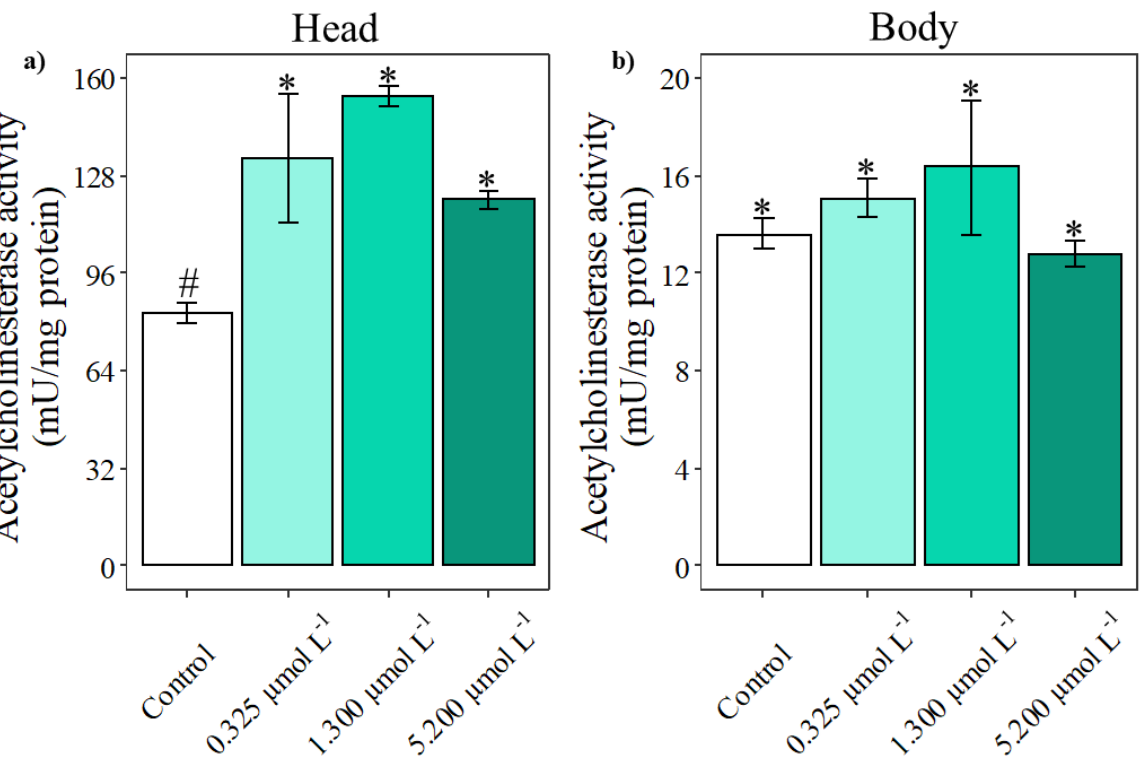
Figure 4. Acetylcholinesterase (AChE) activity of Drosophila melanogaster exposed to three concentrations of 2-Phenylethynyl-Butyltellurium (PEBT) in the head (a) and body (b), after 48h of exposure. * Significant difference compared with #. # Significant difference compared with